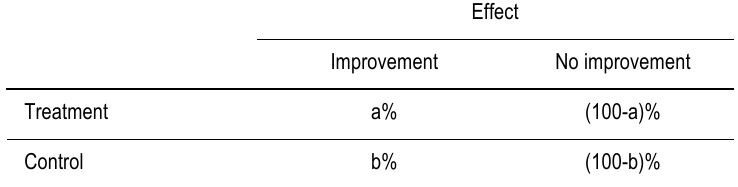
Table 4. The usual statistical between-group comparison